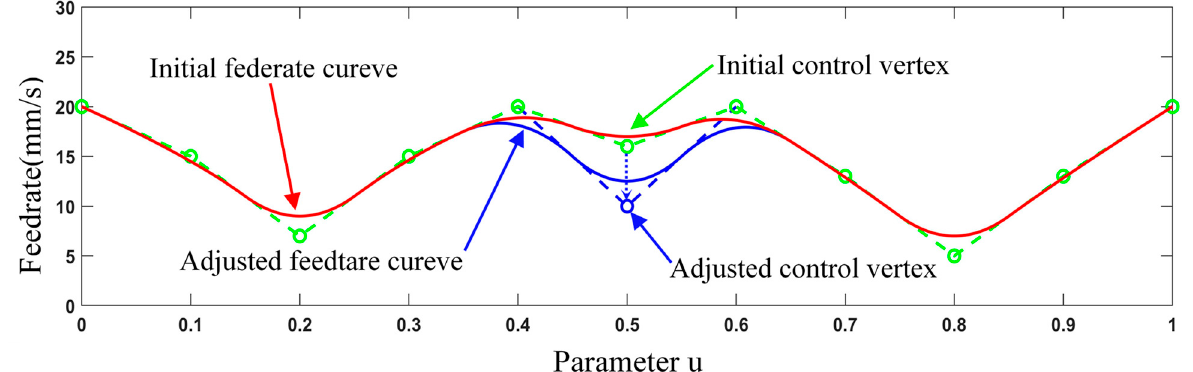
Figure 3. Local readjustment capability of feedrate curve.